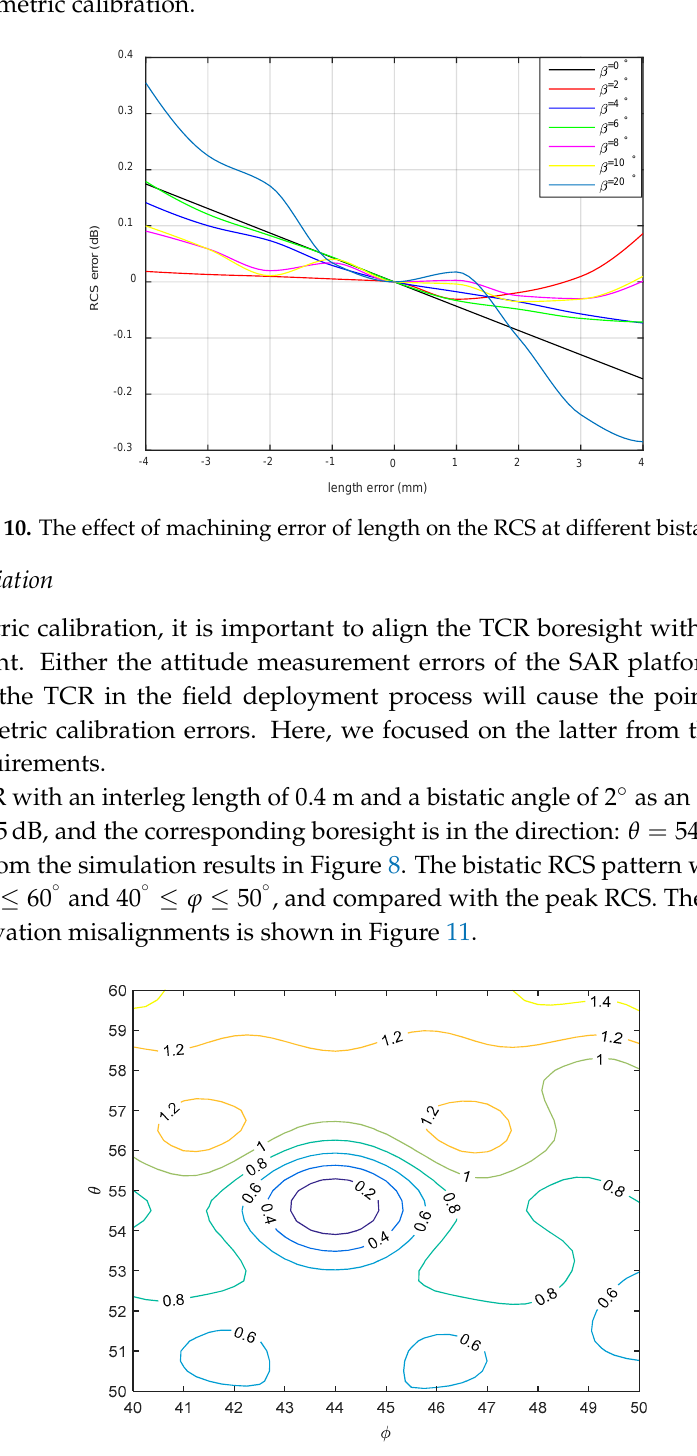
Figure 11. The contour map of the RCS loss due to pointing deviation.